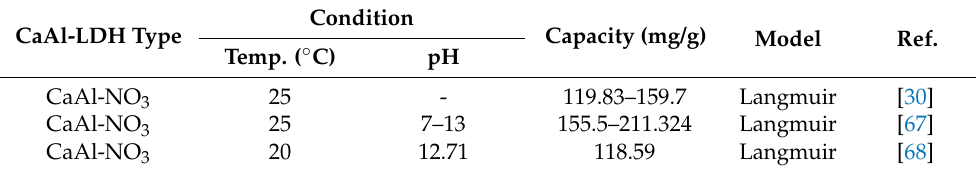
Table 3. Potential Chloride removal capacity of CaAl-LDH phases in previous studies